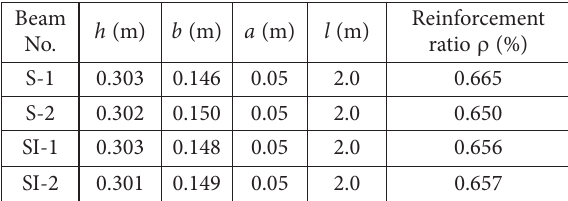
Table 1. Properties of specimens